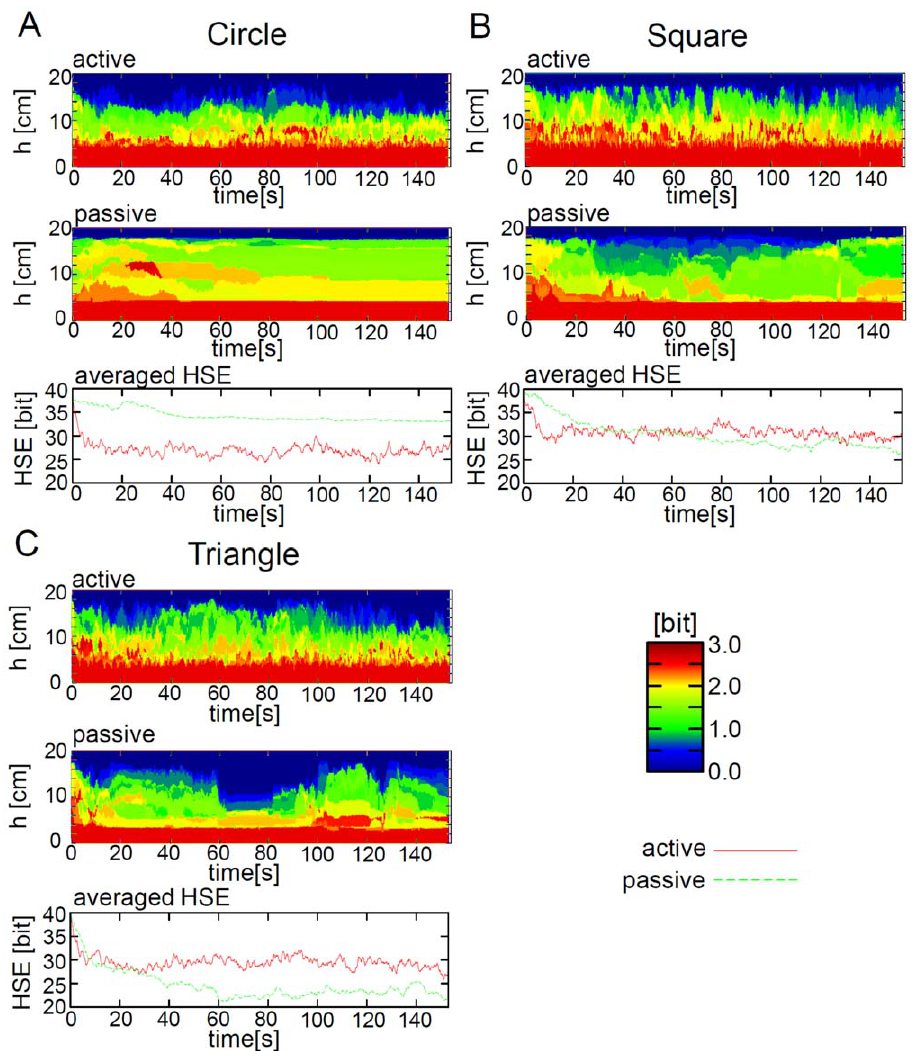
Figure 8. Typical examples of the SSE and the averaged HSE. A , B , and C show the circular, square, and triangular cases, respectively. For each shape, the upper and middle diagrams show the typical example of the SSE ( H ( h ) ) according to h for each time for the active and passive elements, respectively. For each diagram, the brighter the color, the larger the value. The lower diagram shows the averaged HSE ( S ( R ) ) for the active and passive elements. The active and passive elements are overlaid in the same diagram. By calculating the HSE for the active and passive elements for each time and each trial, we averaged the values over all of the trials for each time.